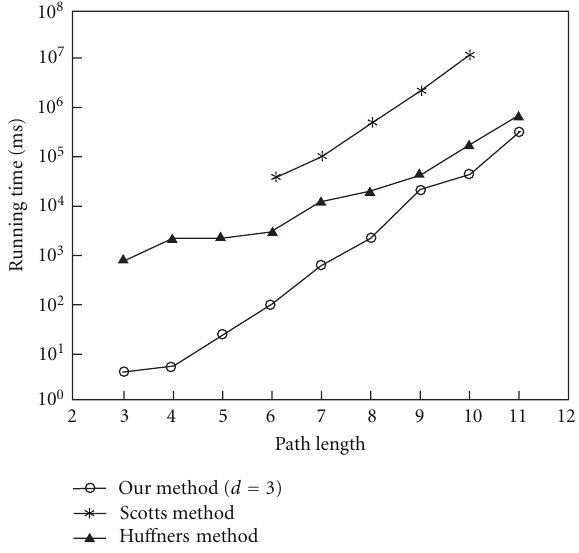
Figure 9: The comparison of runtime in human prostate cancer networks between Scott’s, Hu ff ner’s method, and our